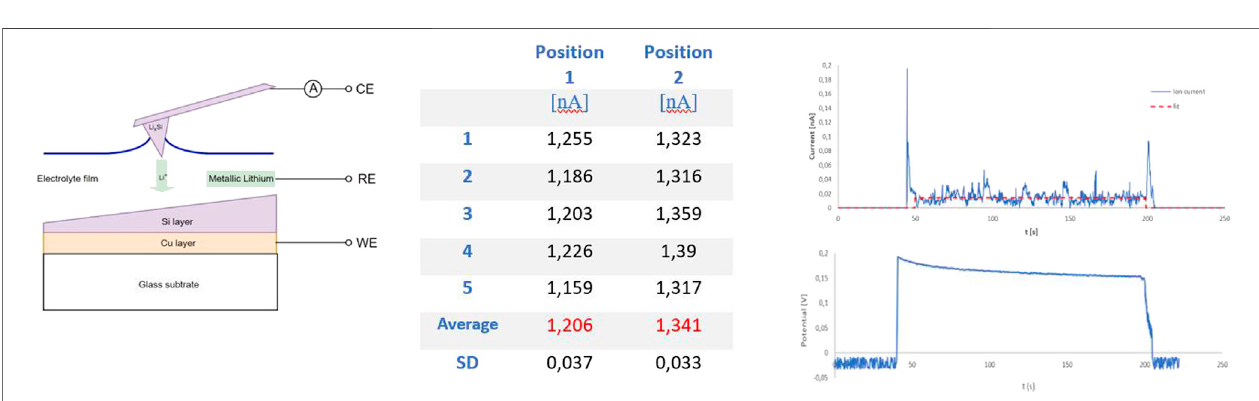
Frontiers in Chemistry |